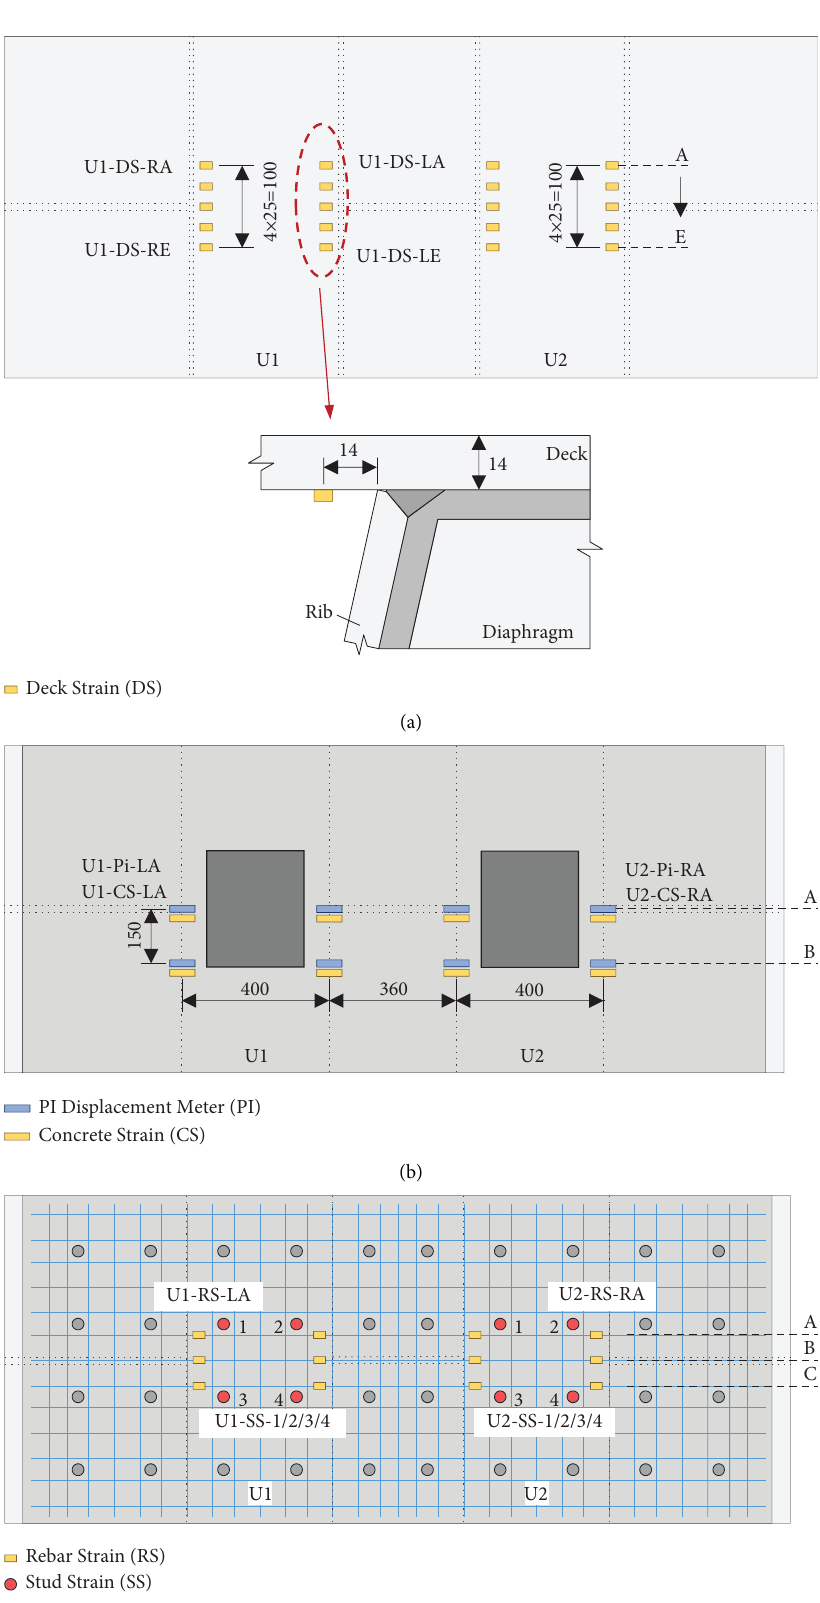
Figure 7: Instrumentation of transverse specimen (unit: mm): (a) deck strain; (b) UHPC strain; and (c) headed stud strain and rebar